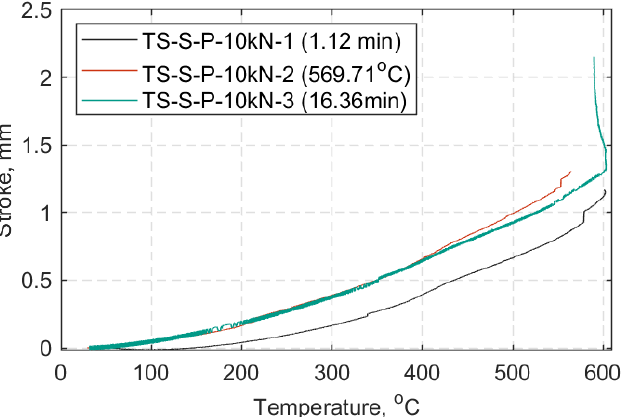
Figure 22. Crosshead stroke in hold mode (mm) vs. temperature (°C): All transient state (TS) cases at 10 kN.